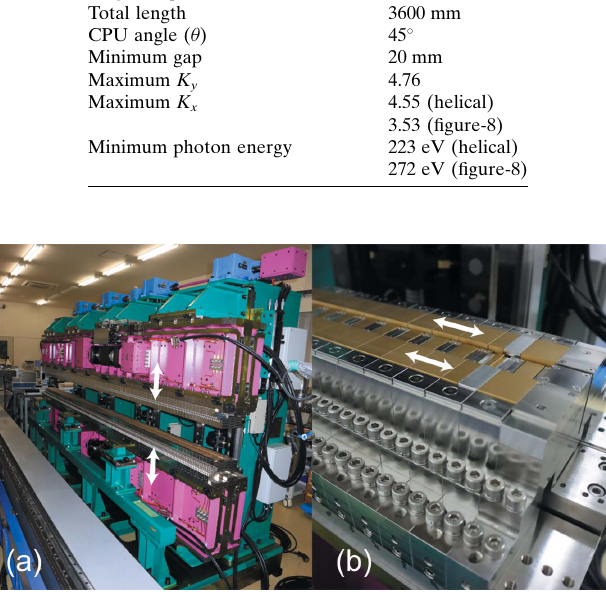
Figure 3 Photograph of HEU120 under construction: ( a ) mechanical frame and ( b ) magnetic arrays C, D and